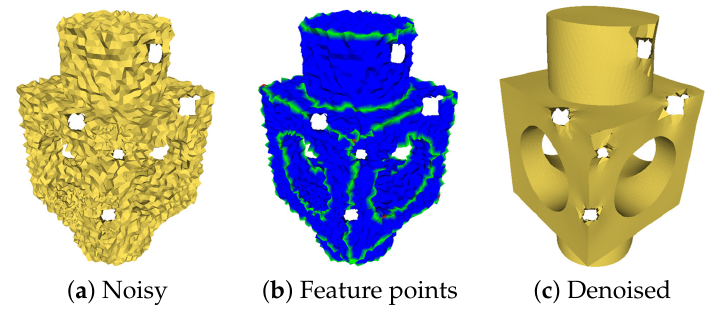
Figure 20. Denoising meshes with small